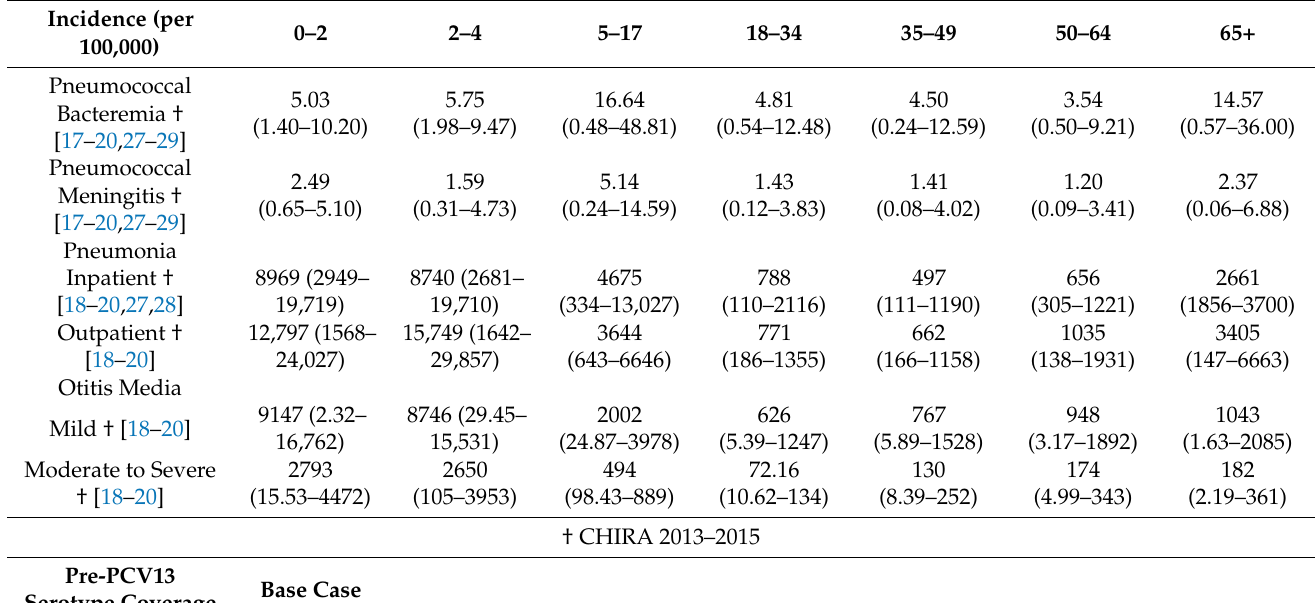
Table 1. Clinical Model